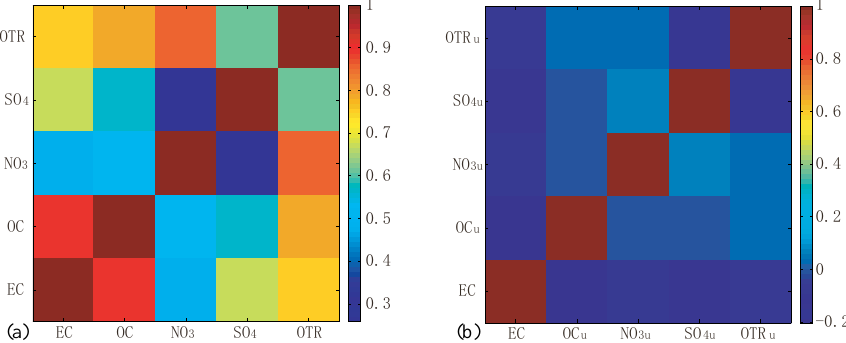
Figure 3. Cross-correlations between the five variables of the BEC. These variables are (a) full variables and (b) unbalanced variables of EC, OC, NO 3 , SO 4 and